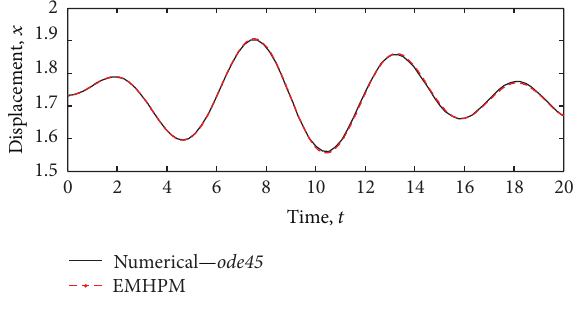
Figure 11: Solution of (40), Δ𝑡 = 1